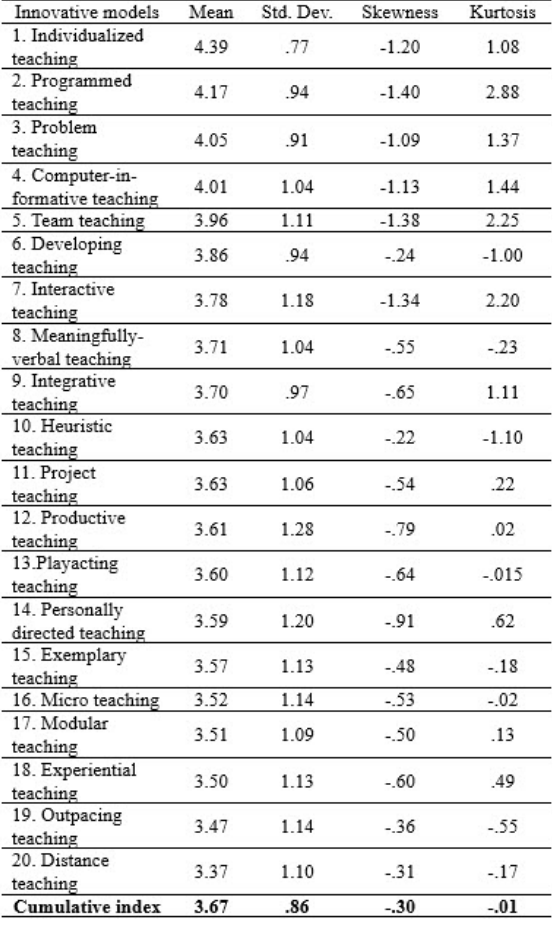
Table 1. Descriptive statistics for